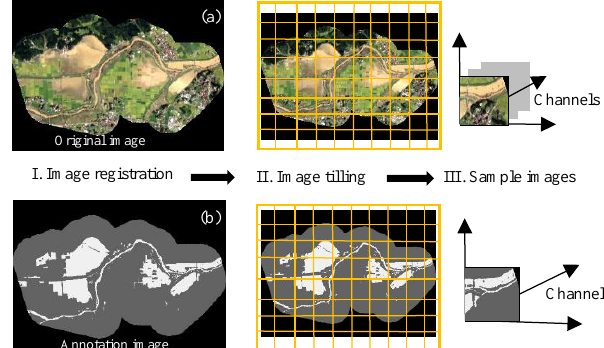
Figure 5. Training image sample preparations ((a) True colour composite of SPOT image (b) corresponding annotation image of Osaki Japan) © SPOT image AIRBUS DS